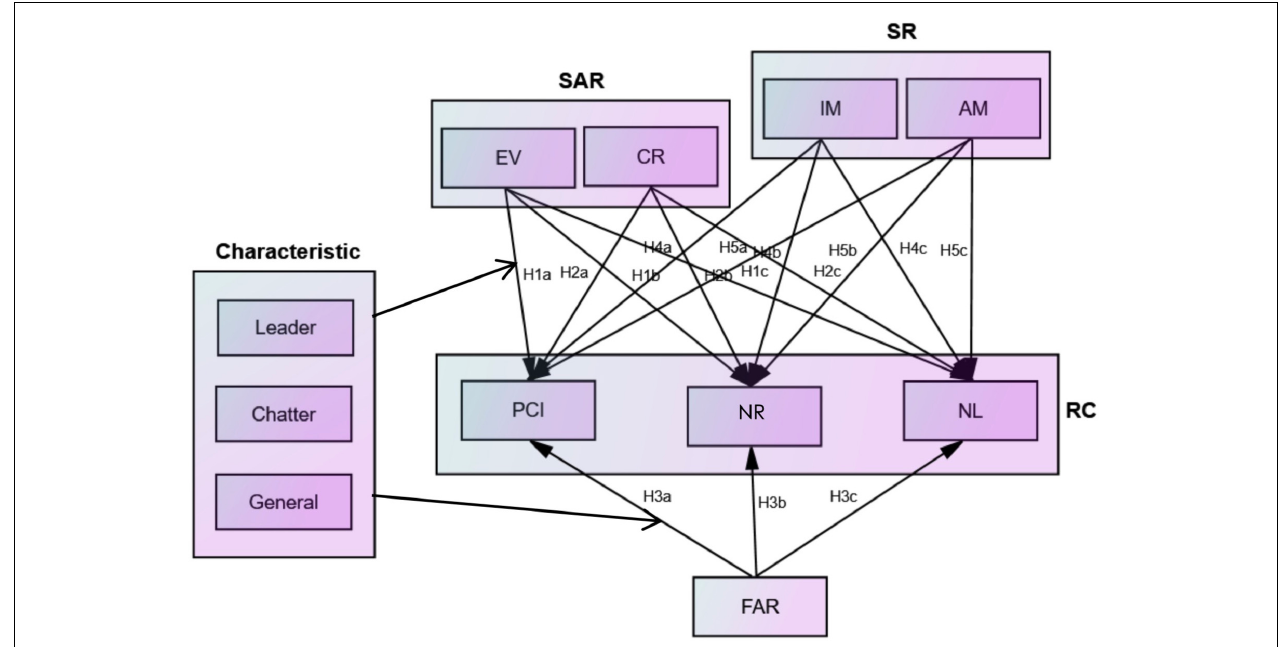
FIGURE 2 | Theoretical model.